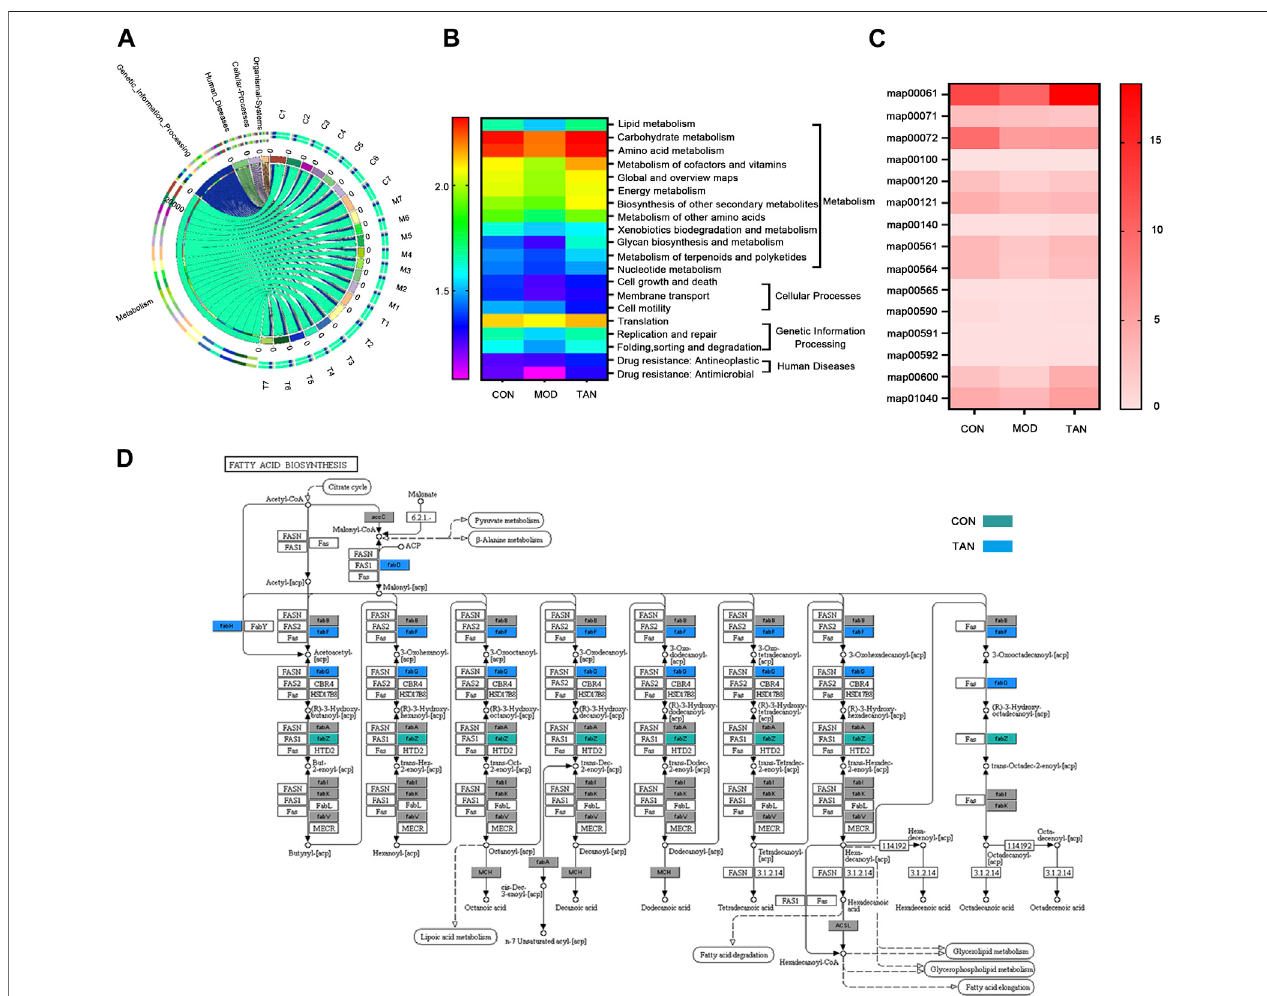
FIGURE7| FunctionalcomponentsinthegutmicrobiomethatweremodulatedbyTANagainstHFDandSTZ-induceddiabetesusingtheHUMAnN2program( n = 7 rats in each group). (A) Altered KEGG pathways (level 1) among the three groups as shown in the Circos plots. (B) Heat map of the altered KEGG pathways (level 2) among the three groups. (C) Heat map of the altered KEGG mapping among the three groups. (D) KEGG map00061 with altered genes in the CON and TAN groups. TAN, tanshinone IIA; KEGG, Kyoto Encyclopedia of Genes and Genomes.